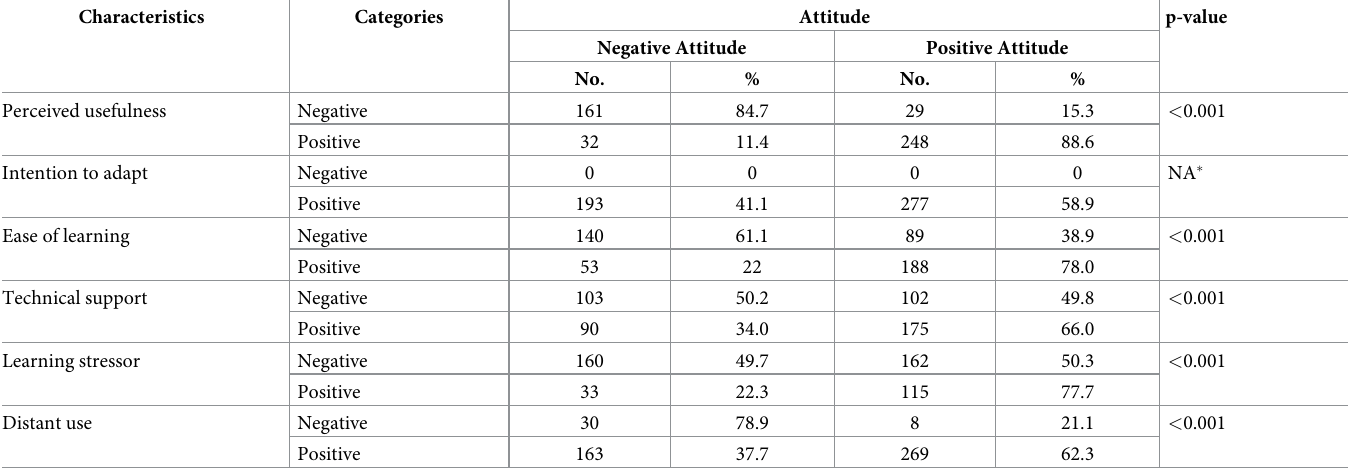
Table 11. Domain wise response of students regarding e-learning (n = 470).